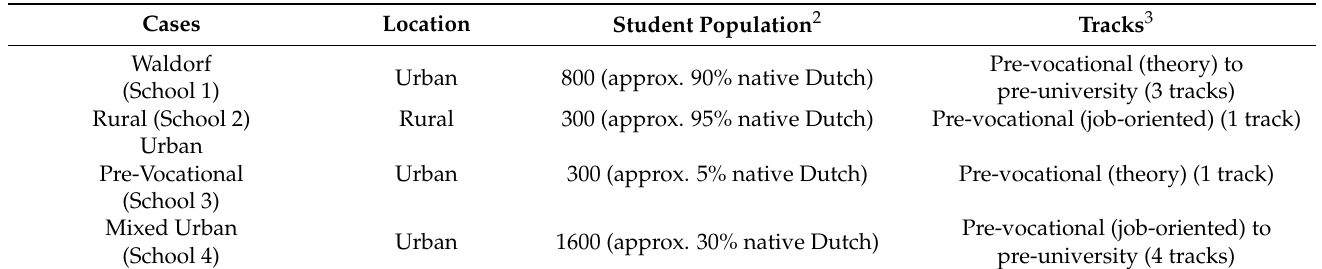
Table 1. Overview of the